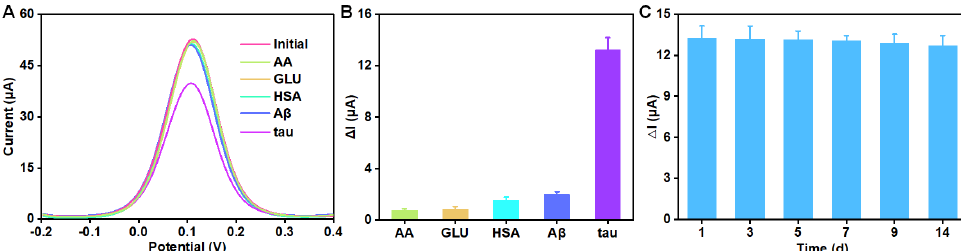
Figure 4. The selectivity and stability of this sensor. ( A ) DPV signals of 10 pg/mL tau and 10 ng/mL AA, GLU, HSA and A β . ( B ) A comparison of this aptasensor response towards tau and interfering molecules. ( C ) The changing value ( Δ I) of peak current for detecting 10 pg/mL tau at different times.